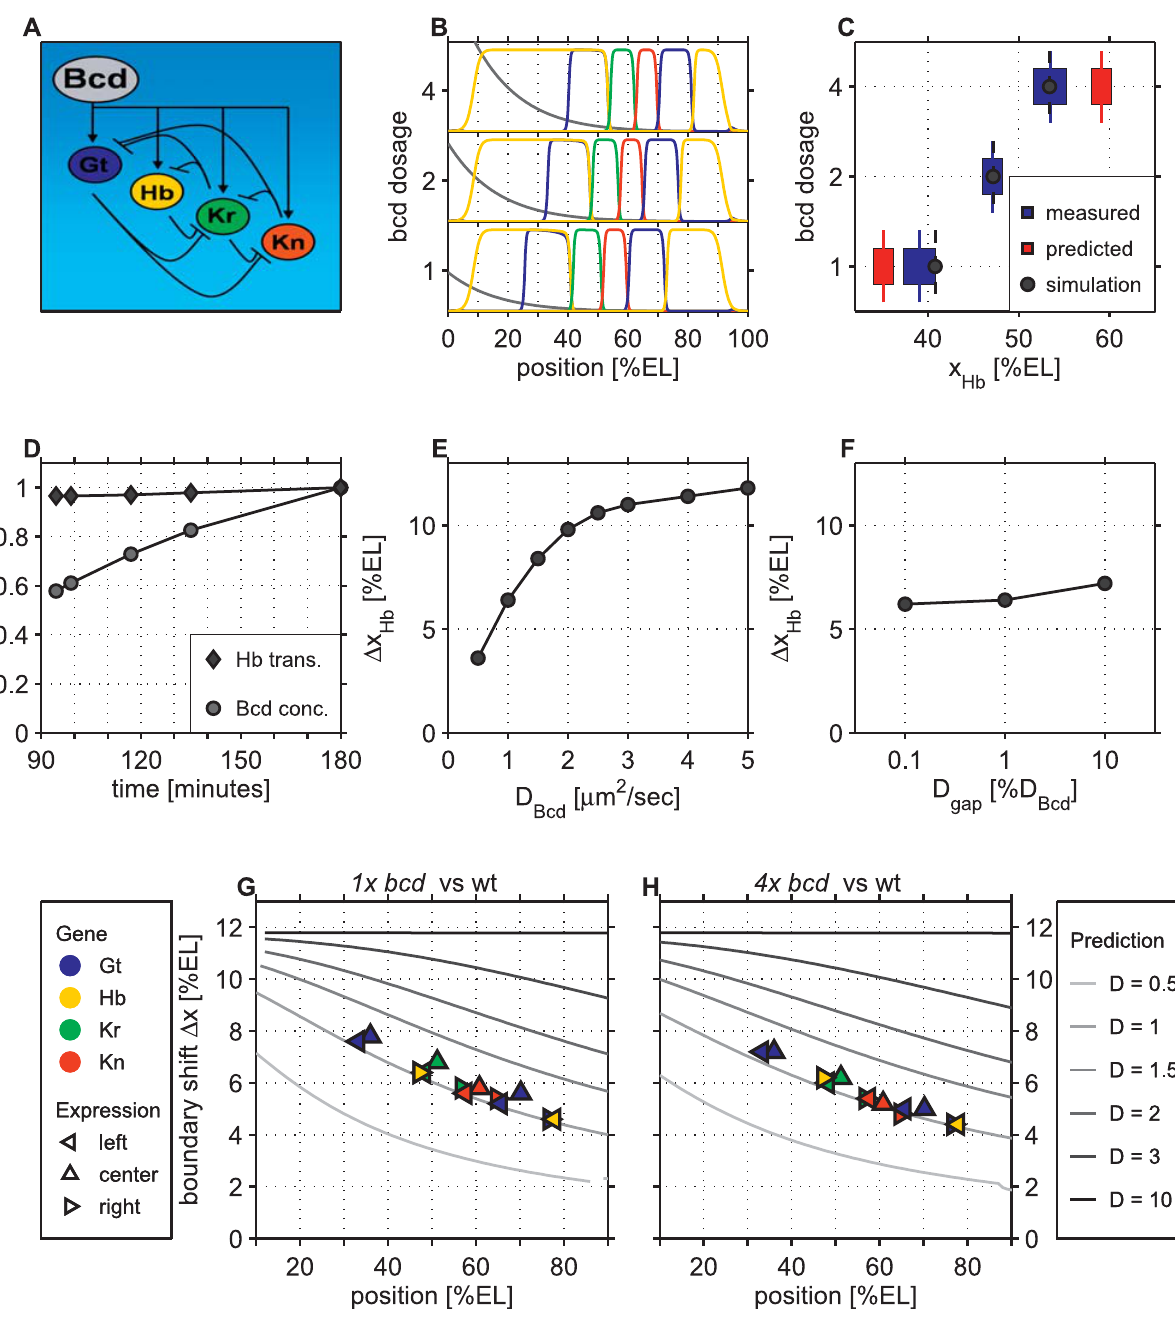
Figure 1. In Silico Simulation of the Gap Gene Network (A) A scheme of the gap gene interactions used: Bcd activates the expression of the gap genes in a concentration-dependent manner. Most gap genes mutually suppress each other (see Figure 9 in [45,46]). These interactions were modeled by a set of reaction diffusion equations, as specified in Protocol S1. (B) Spatial distributions of the different network proteins (color-coded as in [A]), at a time when the Bcd gradient has fully evolved and is close to exponential are shown for different bcd dosages. The gap genes are expressed in adjacent stripes, consistent with their in vivo expression domains. (C) The position of the Hb expression boundary in wild-type embryos (with 2 copies of bcd ) and in embryos bearing altered bcd dosage (one and four copies, as shown). The results in our simulation (black circles) are compared to the experimental measurements (blue bars). Also shown is the prediction based on a steady-state gradient (red bars). (D) The temporal change in the position of the Hb expression boundary (diamonds) and in the Bcd concentration at this position (circles) are shown. We considered the wild-type situation (2 3 bcd ) and show the behavior following the initialization of gap gene expression. (E) We performed the simulations for different values of the Bcd diffusion constant D . Shown here is the shift of the Hb expression boundary in embryos with one bcd allele (1 3 bcd ) with respect to the wild-type as a function of D . (F) Same as in (E) but for different values of the gap gene diffusion constant. (G) Shifts of gap gene expression domains (center, left and right boundary, if applicable) in embryos with one functional bcd allele (1 3 bcd ) as a function of the wild-type (2 3 bcd ) position. (H) Same as in (G) but simulating embryos with four copies of bcd (4 3 bcd ). doi:10.1371/journal.pbio.0050046.g001 PLoS Biology |